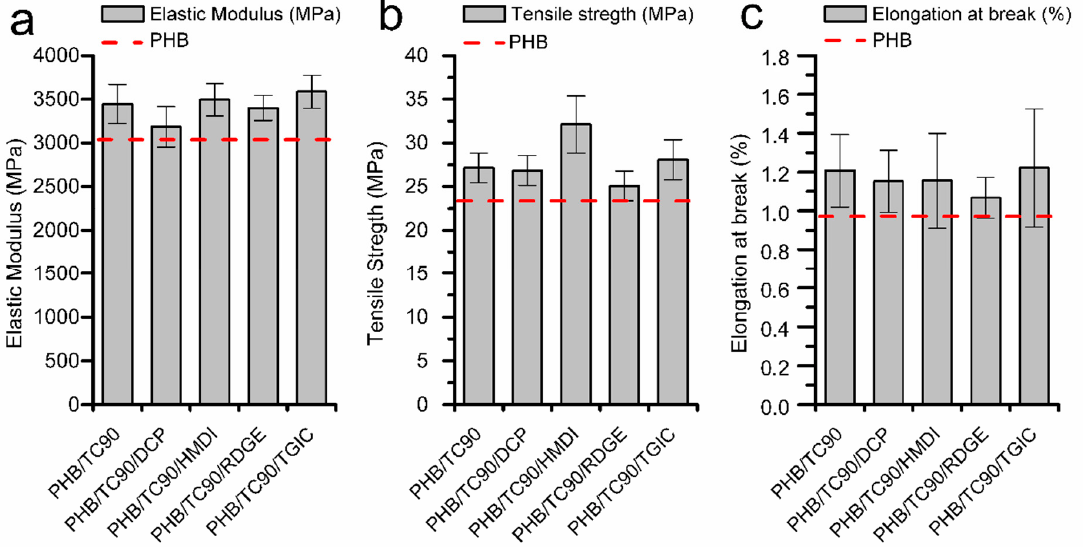
Figure 4. ( a ) Elastic modulus, ( b ) tensile strength, and ( c ) elongation at break of aged samples of neat PHB and PHB / TC90 composites with and without reactive agents.